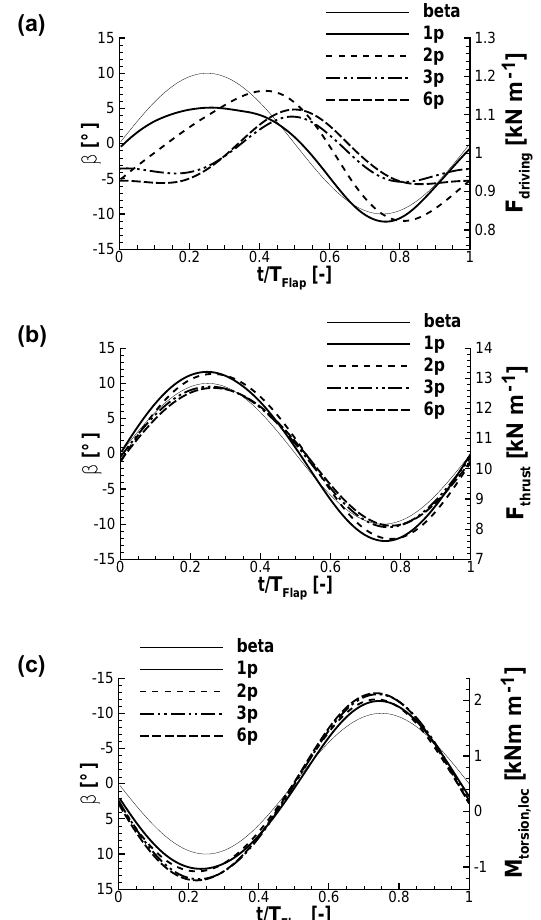
Figure 11. Variation in flap frequency, 75% blade cut (driving force, a ; thrust, b ; and local torsion moment, c